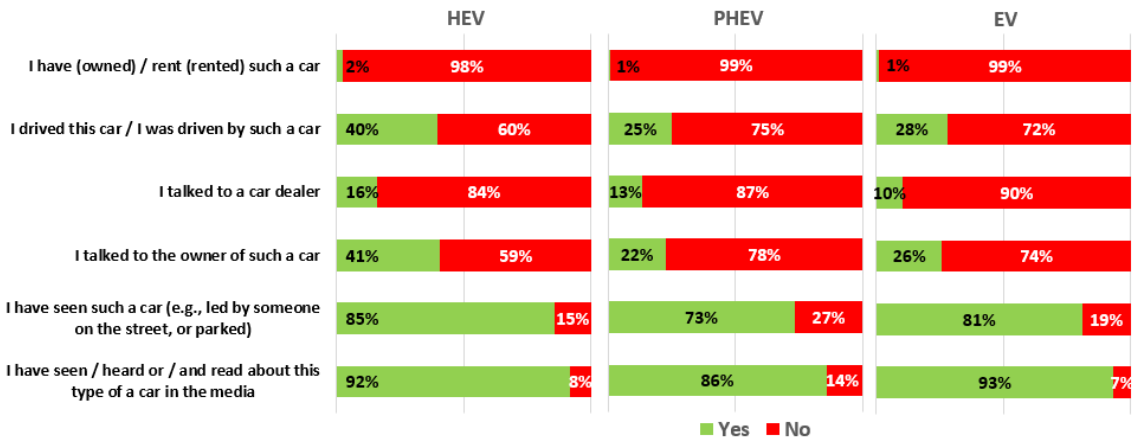
Figure 7. Sources of AFV